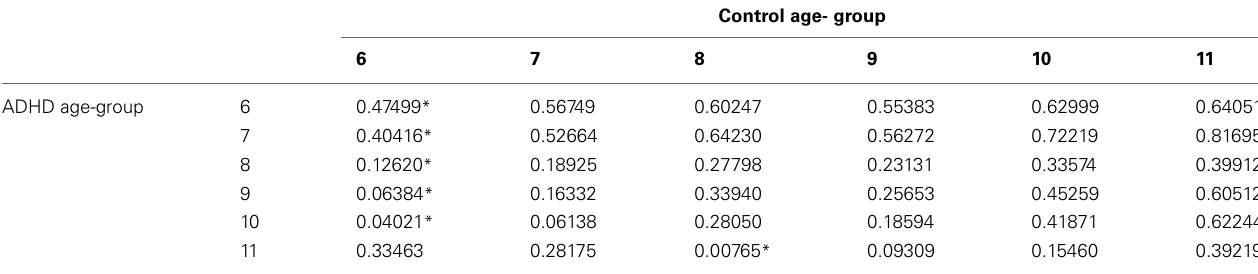
Table B4 | ADHD and control groups with the minimal difference in the impulsivity parameter, using Cohen’s D